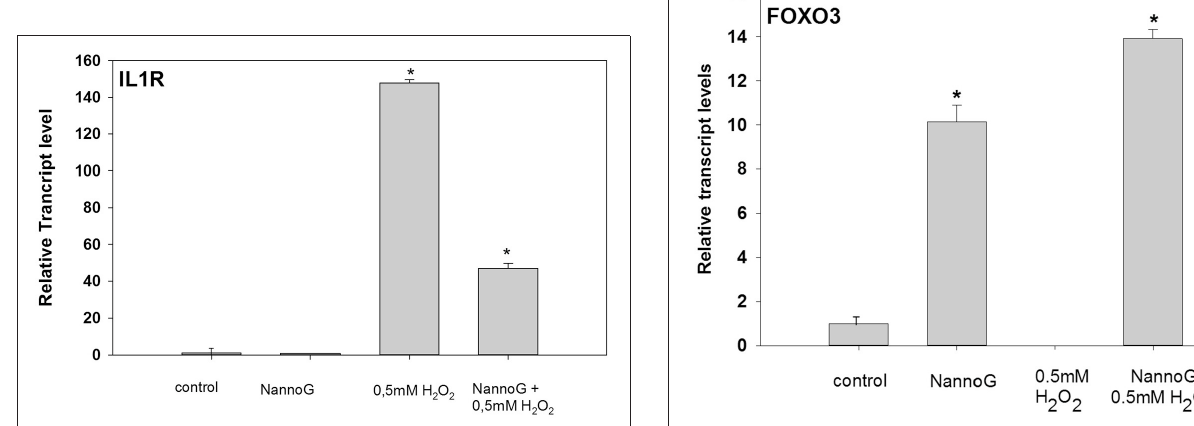
FIGURE 7 | Relative transcript accumulation of IL1R. The experimental conditions are: cells treated with H 2 O 2 0.5 mM, cells treated with NannoG (408 µ g/ml), pre-treated cells with NannoG and stressed with H 2 O 2 (0.5 mM). * p < 0.05 significantly different from control.